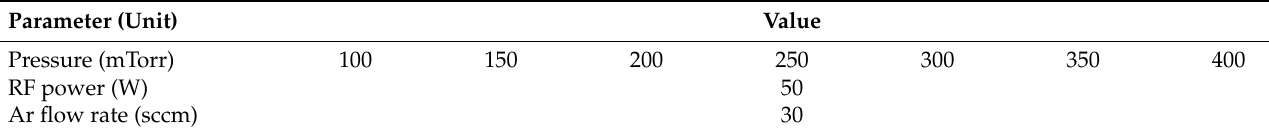
Table 3. Experiment conditions for RF power change.